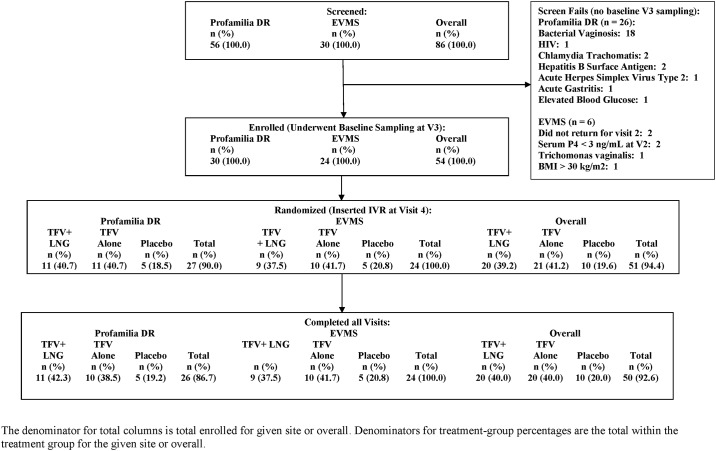
CONSORT figure CONRAD A13-128 study population.